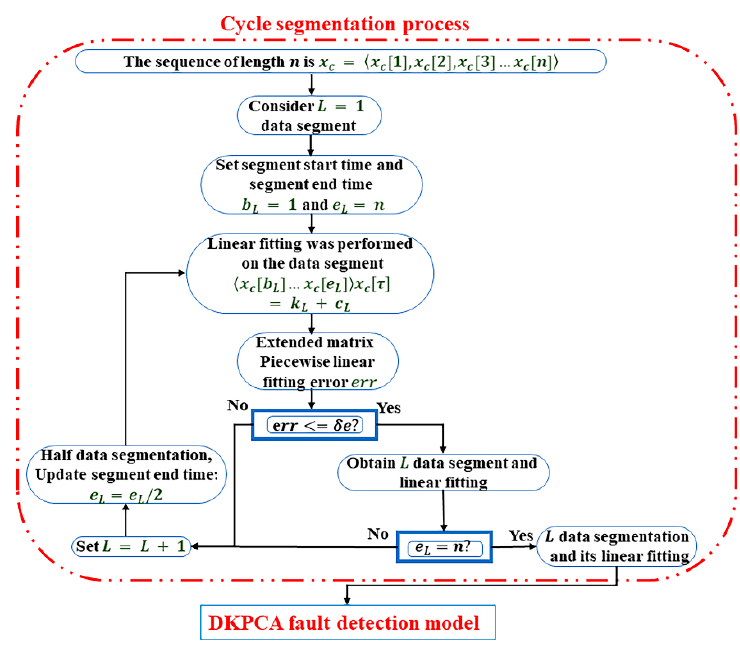
Figure 3. Cycle segmentation process of fault